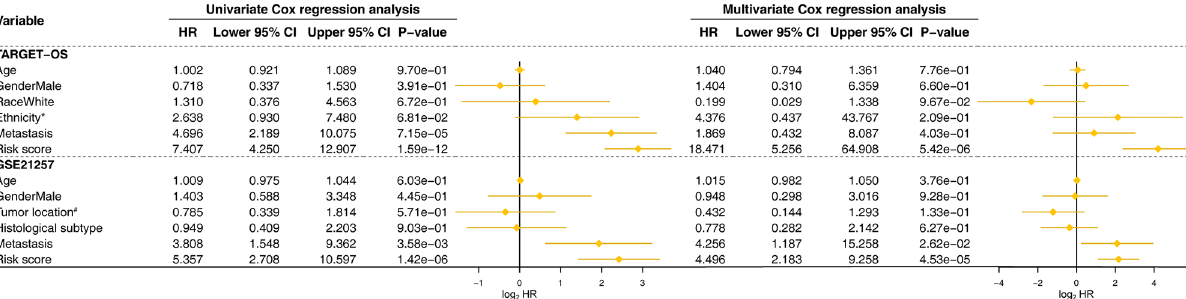
Figure 5. Univariate and multivariate Cox proportional-hazards models that built for testing the predicting ability of the seventeen-gene signature in two cohorts. HR hazard ratio, CI confidence